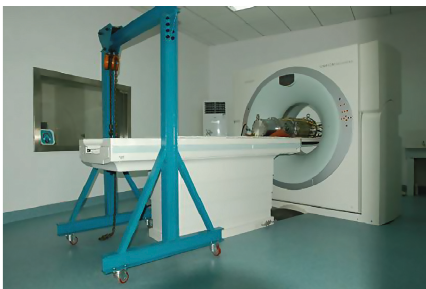
Figure 1: X-ray CT visualization